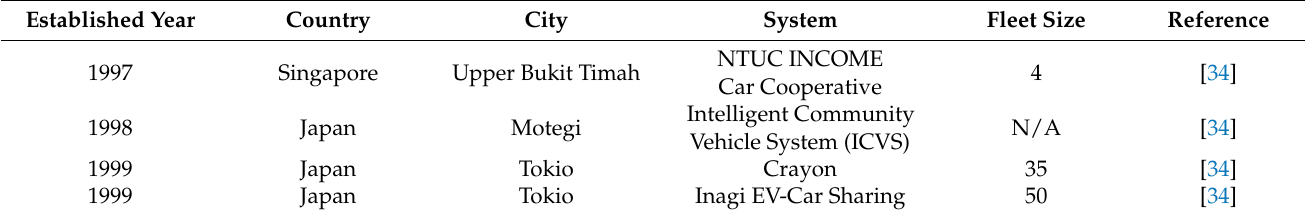
Table 3. List of selected car-sharing systems operating in Asia in